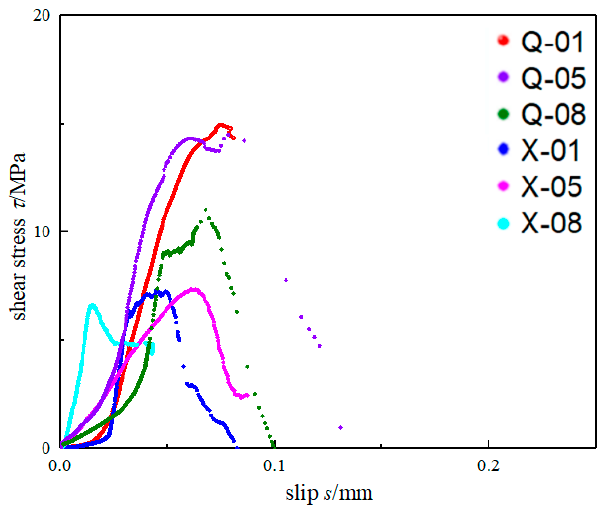
Figure 3. Bond–slip curves.